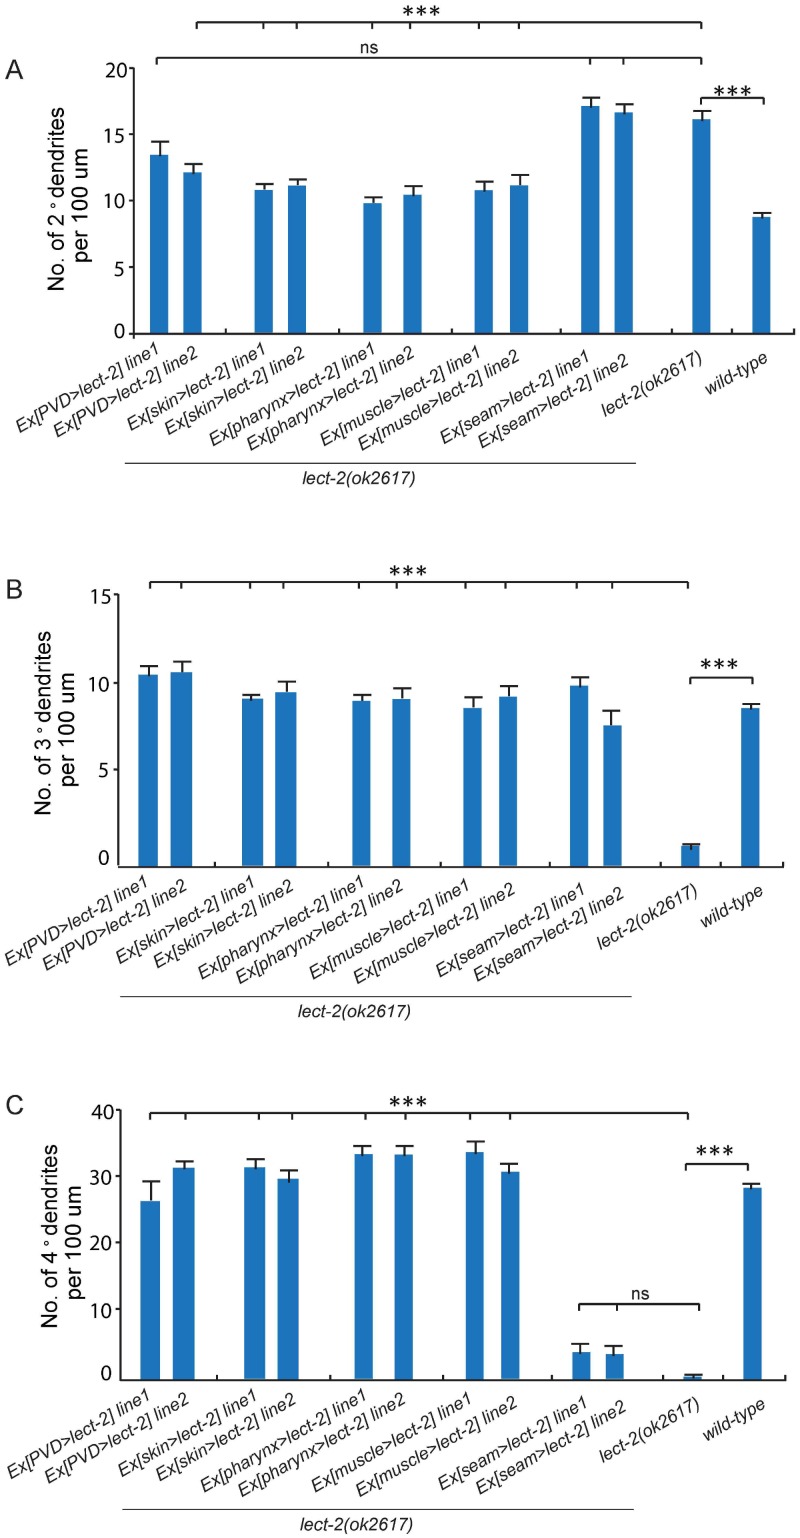
PVD patterning defect of lect-2 mutants is rescued by over-expressed LECT-2 secreted from multiple types of tissues.(A–C) Quantifications showing the number of 2°, 3° and 4° dendrites in a 100 μm region anterior to the cell body of PVD neurons. One way ANOVA with the Tukey correction was used for statistical analysis. ***p<0.0001. ns: not significant. Data are represented as mean ± SEM. 12 animals were quantified for each genotype. ser2prom3, Pdpy-7, Pmyo-2, Phlh-1 and Pnhr-81 were used to express LECT-2 in PVD neurons, epidermis, pharyngeal muscles, body wall muscles and seam cells, respectively.